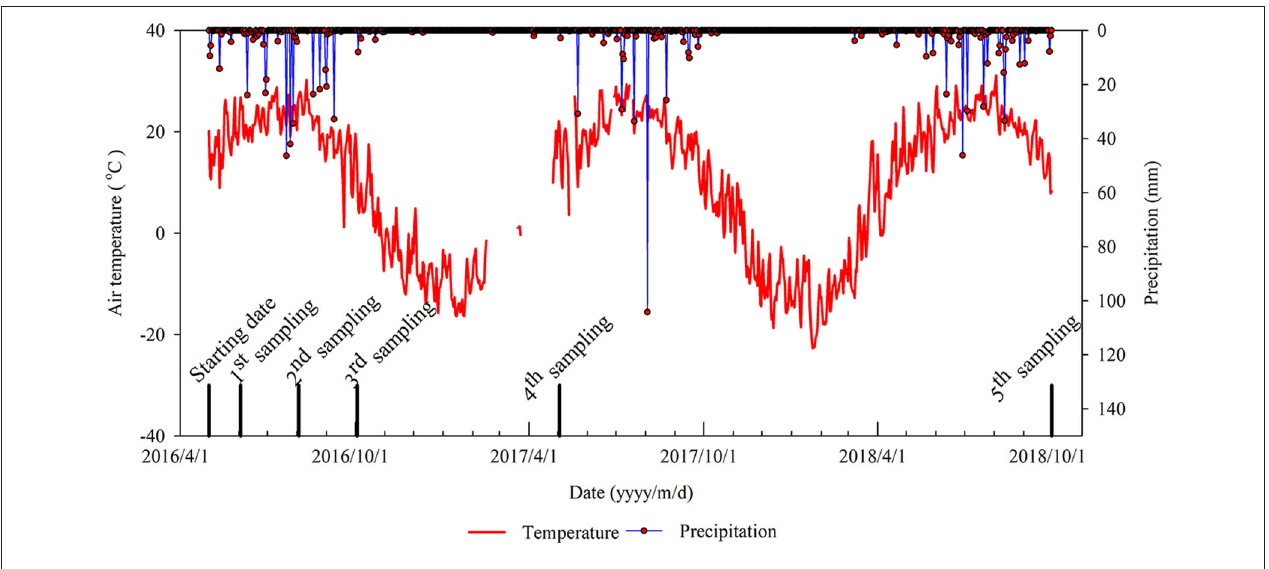
FIGURE 2 | Precipitation and air temperature during the study period.